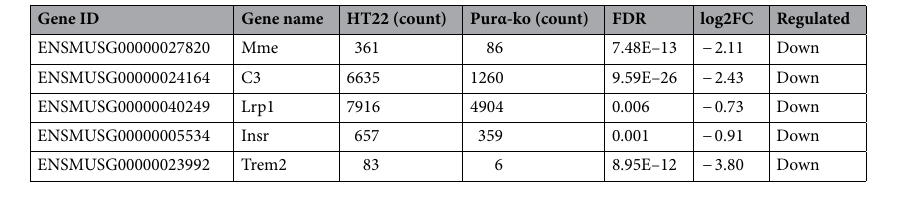
Table 3. Differential gene enriched in amyloid-beta